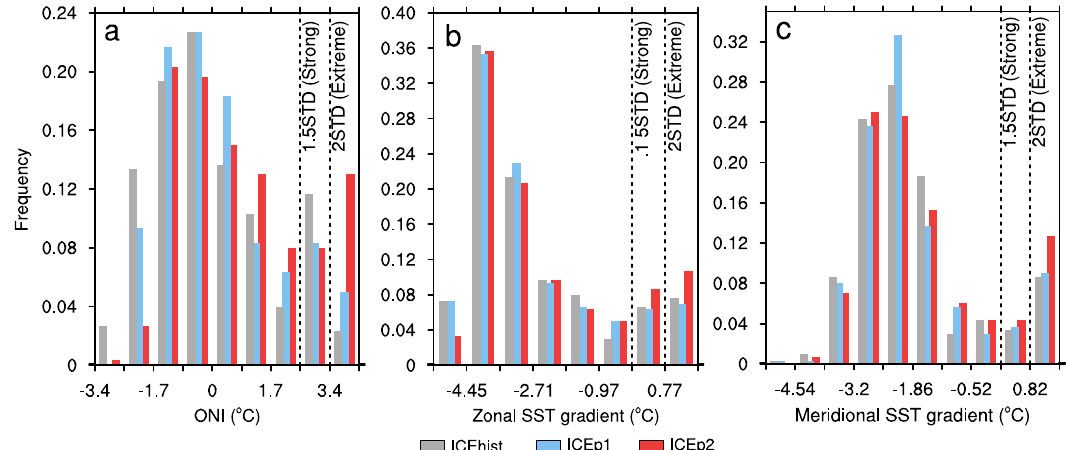
Fig. 1 | Histograms of El Nin ̃ o indices associated with Arctic sea-ice loss experiments.a TheOceanicNin ̃ oIndex, b thezonalsea-surfacetemperature(SST) gradientintheequatorialPaci fi cthatisde fi nedastheaverageSSTovertheNin ̃ o3.4 region (5°S – 5°N, 170°W – 120°W) minus the Maritime Continent region (5°S – 5°N, 110°E – 160°E), and c the meridional SST gradient in the eastern equatorial Paci fi c that is de fi ned as the average SST over 5°N – 10°N, 160°W – 100°W minus